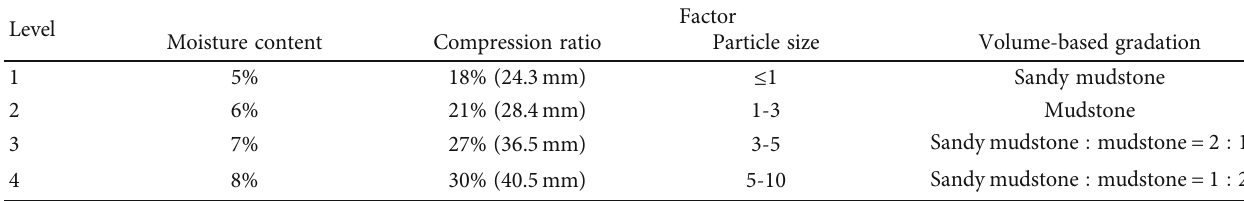
Table 1: Factors and levels in orthogonal design.